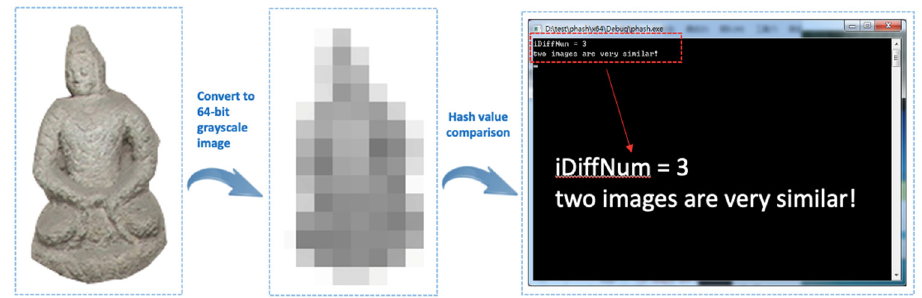
Figure 9. Numerical value generated by pHash algorithm.